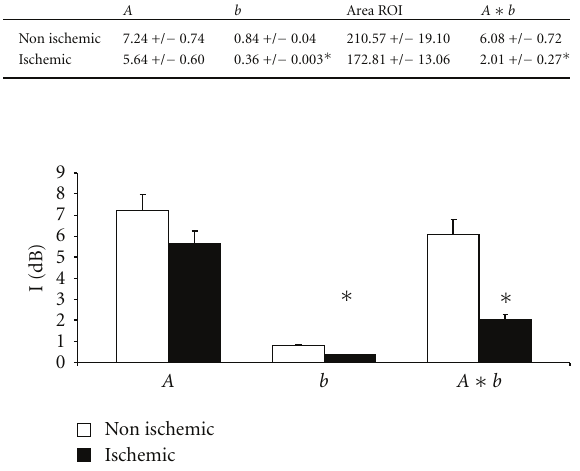
Figure 6: Echocardiographic evidence of defects in perfusion after injection of contrast medium. As shown, myocardial blood flow was significantly decrease in the anterior and lateral areas ( ∗ P < . 05) compared to the healthy zone (inferior wall of the left ventricle).